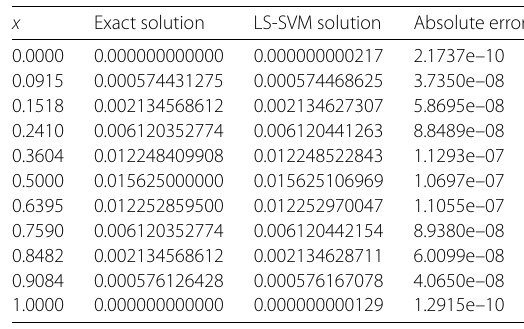
Table 1 Comparison between the exact solution and the LS-SVM solution (Example 1) x Exact solution LS-SVM solution Absolute error